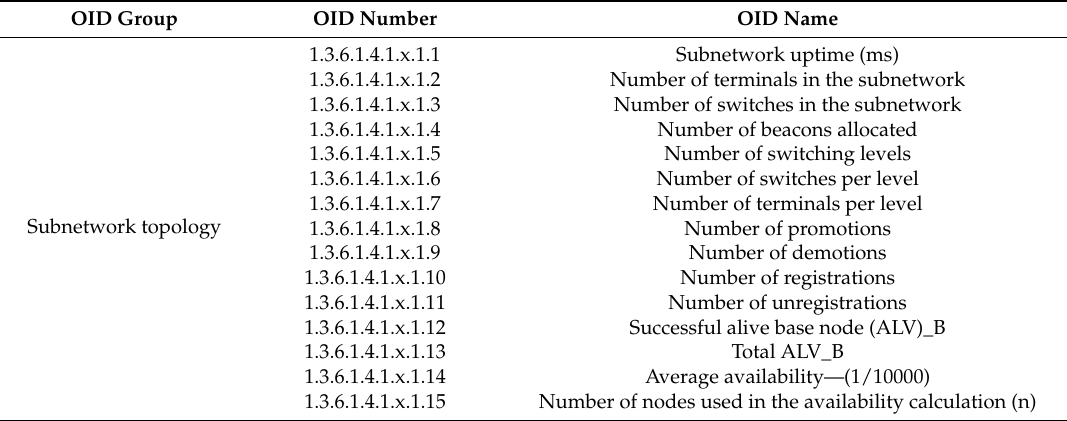
Table 2. Object identifiers (OIDs) of the simple network management protocol (SNMP) management information base (MIB). Media access control: